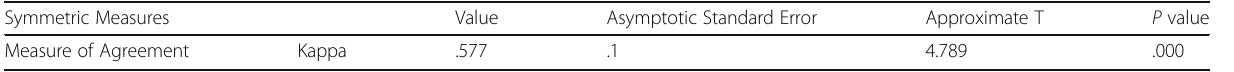
Table 2 Cohen ’ s kappa measures showed the agreement between the results of culture and LE test Symmetric Measures